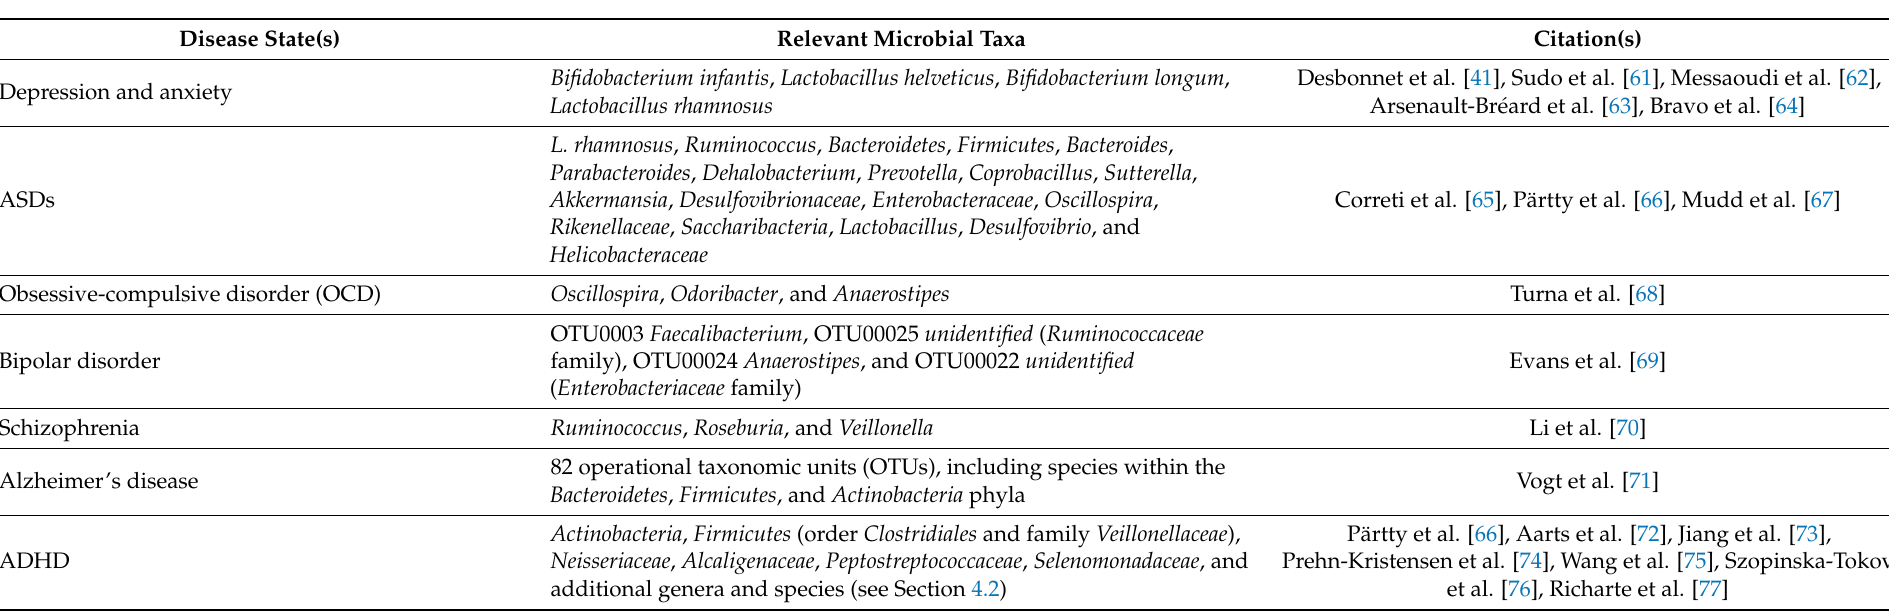
Table 2. Disease states associated with dysbiosis of the gut microbiota and the microbial taxa that have been found to exhibit altered abundance associated with the disease